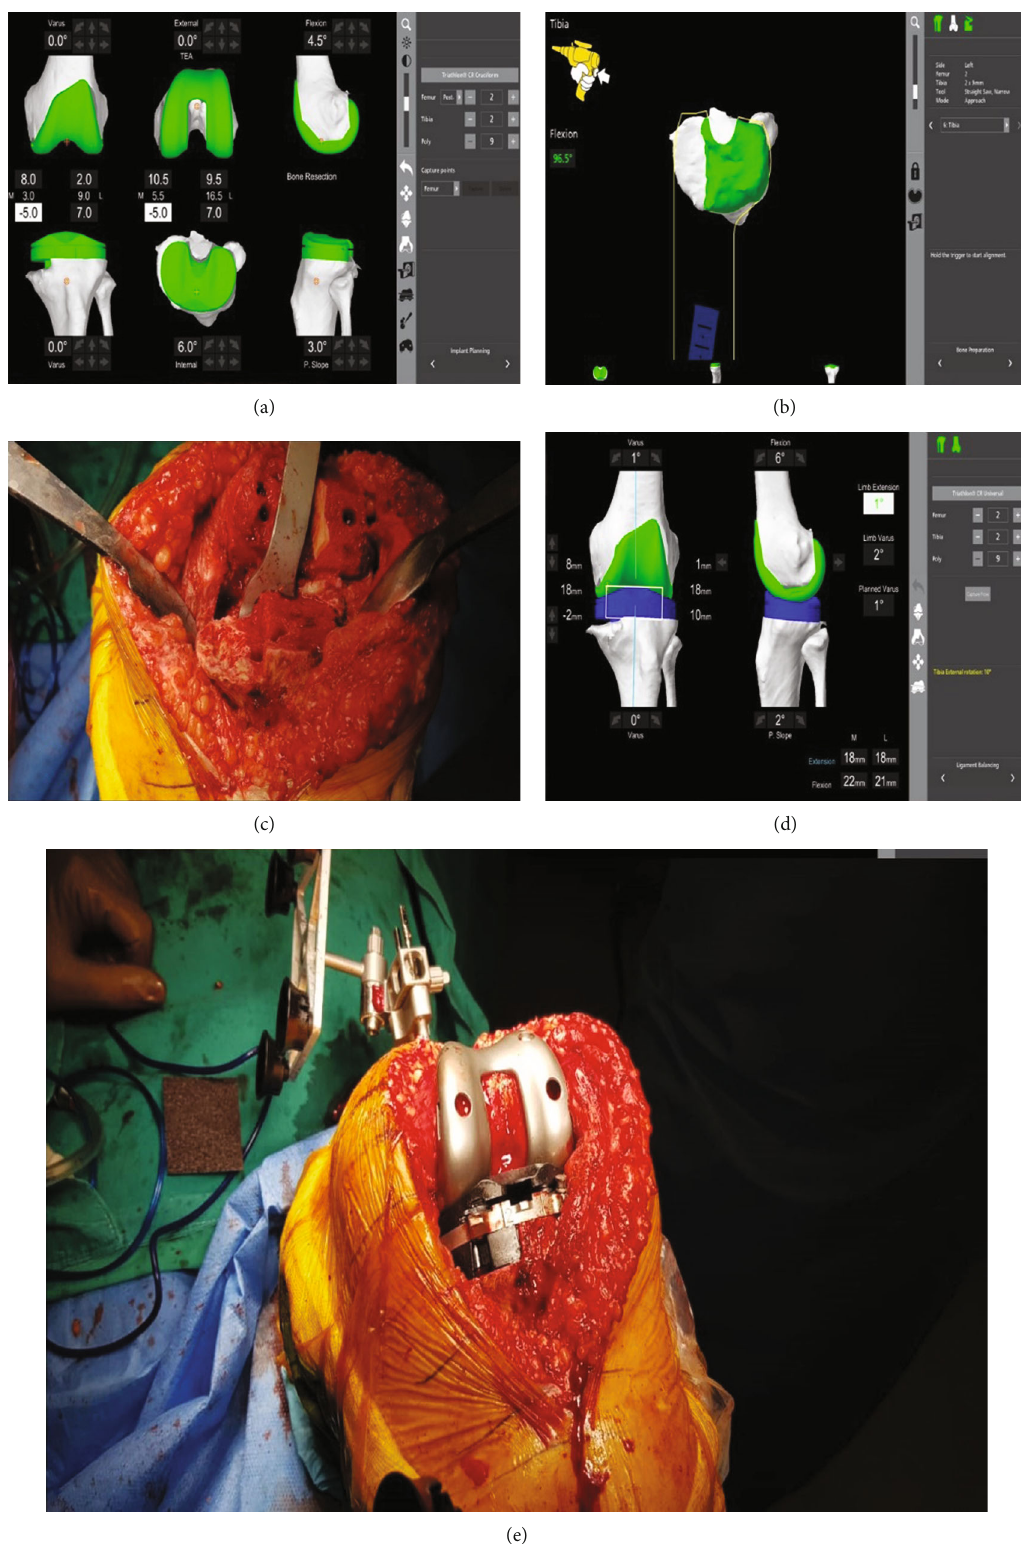
Figure 2: (a) Preoperative planning: distal femur medial resection was 8.0mm and lateral 2.0mm. Posterior femur medial resection was 10.5mm medial and lateral resection was 9.5mm. Posterior Condylar Axis (PCA) was 1.8 ° . Transepicondylar axis (TEA) was 0 ° . (b) Tibial cut was performed with the consideration of moving the resection line of the tibial cut 2 mm distally. (c) Intraoperative picture at that point. (d) Control of stability and range of motion was performed. (e) Final intraoperative picture following prosthesis